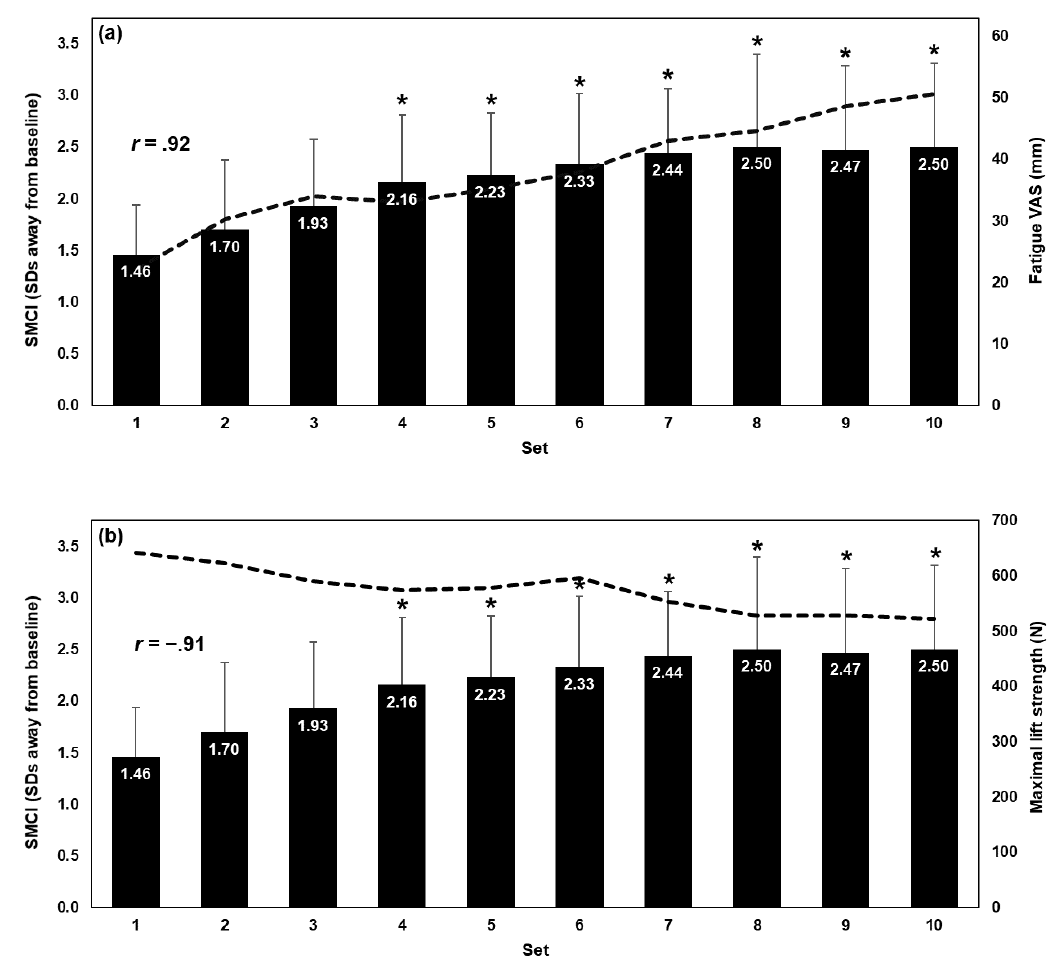
Figure 2. The spine motion composite index (SMCI; bars) plotted with ( a ) fatigue visual analogue scale (VAS; dashed line) and ( b ) and maximal lift strength (dashed line). These data were averaged across participants for fatiguing sets 1–10. Error bars indicate the SMCI standard deviation (SD), and asterisks indicate that the SMCI of that set is significantly greater than set 1. When averaged across participants, strong Pearson’s correlation coefficients ( r ) were observed between the SMCI and fatigue VAS ( r (8) = 0.92, p < 0.001) and between the SMCI and maximal lift strength ( r (8) = − 0.91, p < 0.001).